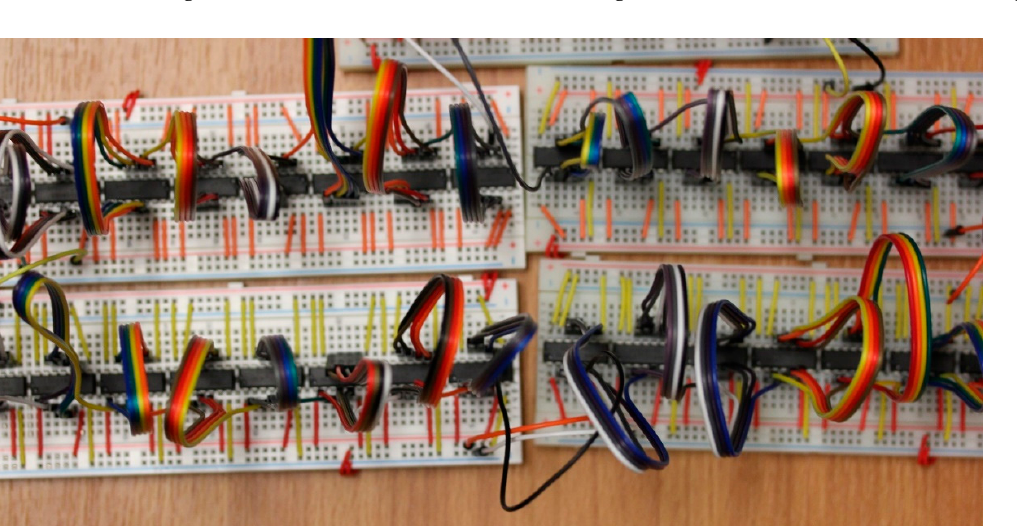
Figure A2. Hardware network implementation—side view.